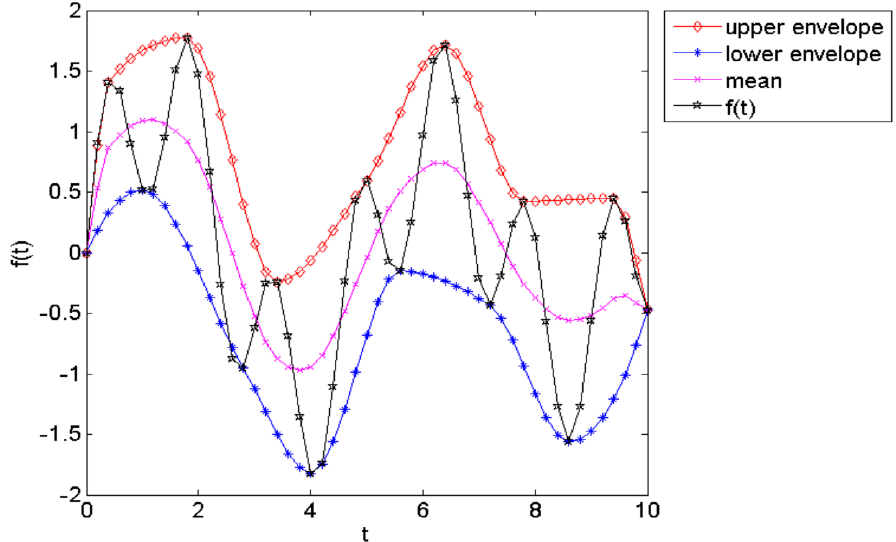
Figure 1. A signal f ( t ) and its mean, upper and lower